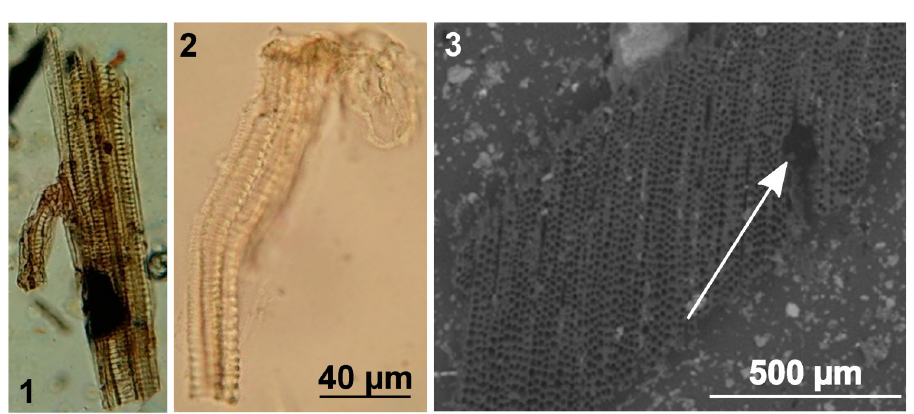
Fig 4. Microscopic observation of (A) archaeological plant tissues trapped in the resin of SFC1; (B) filament from the stamen of a modern wild Vitis vinifera flower, and (C) ESEM observation of a transverse section of charred Pinus wood trapped in the SFC2 pitch. The white arrow indicates the resin